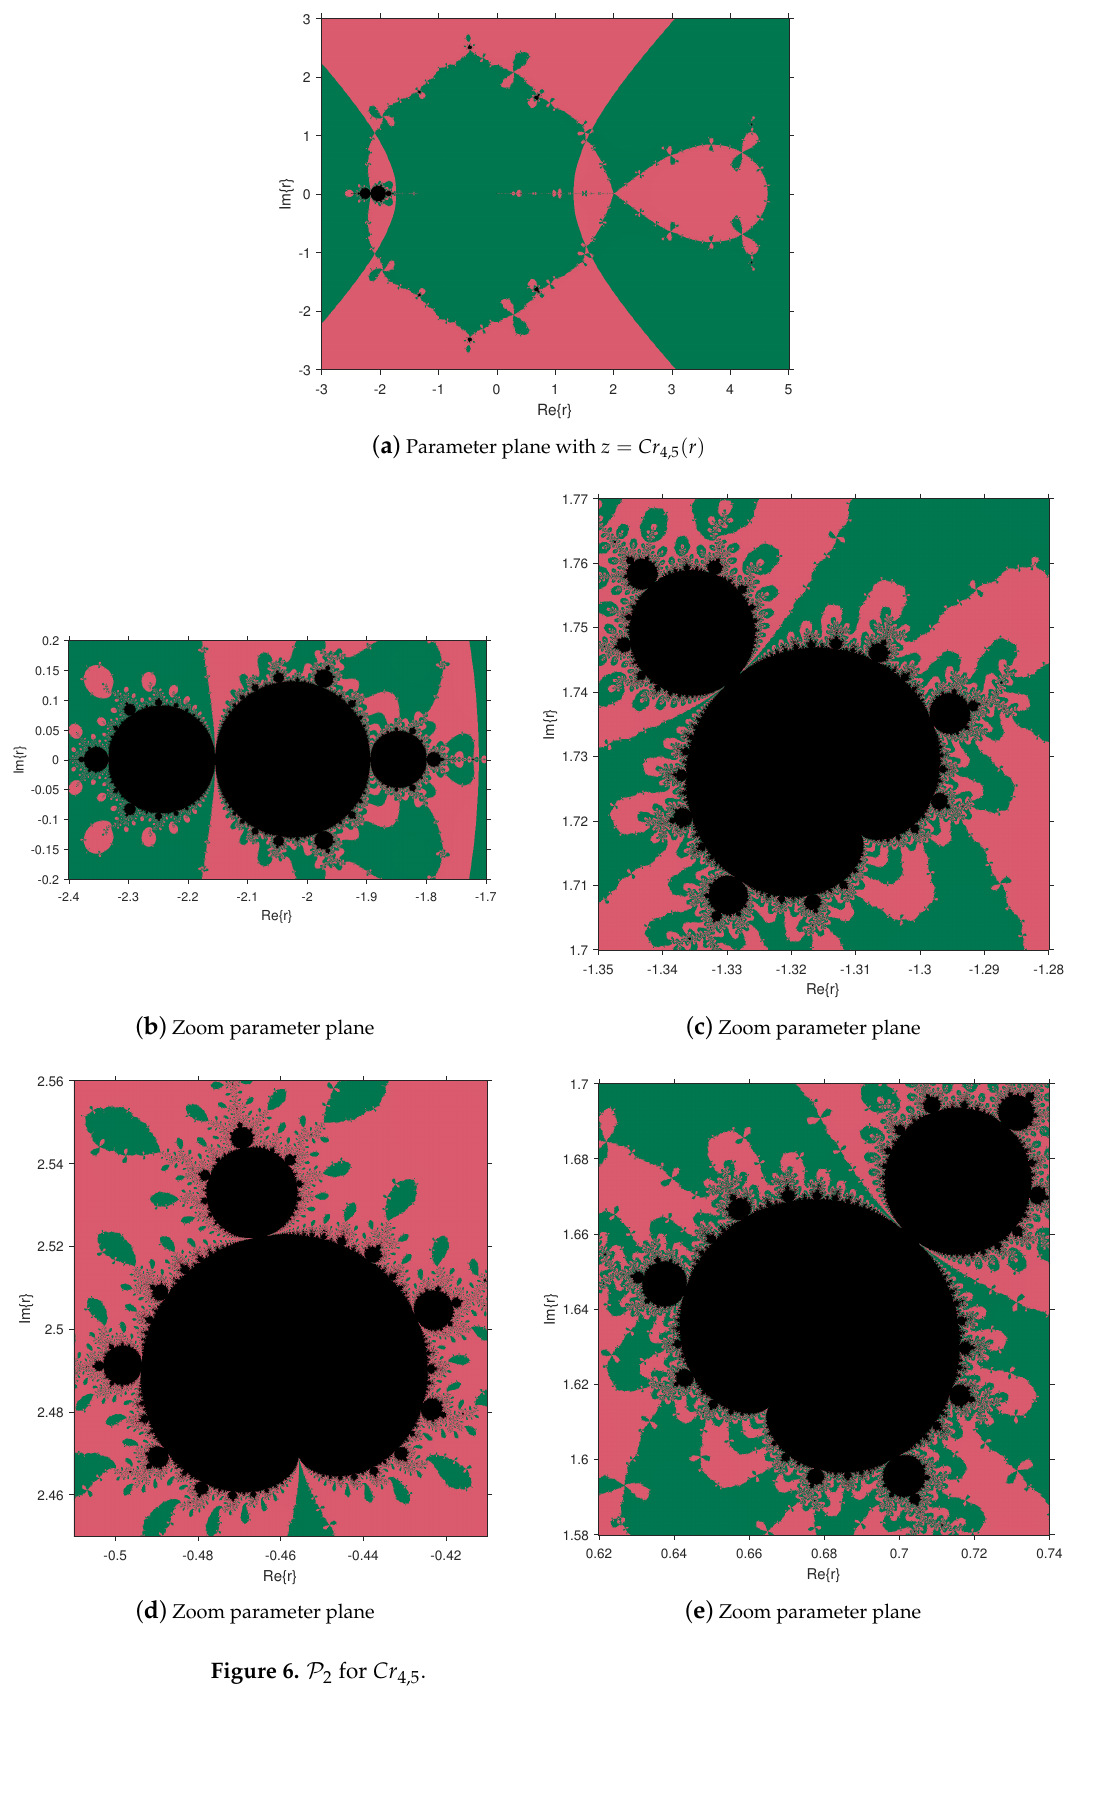
Figure 6. P 2 for Cr 4,5